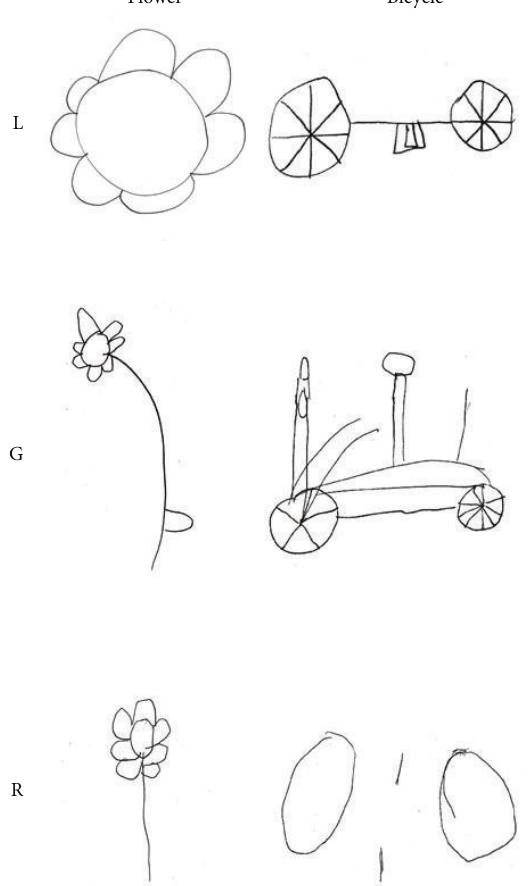
Figure 3: Examples of drawings from memory performed by L., G., and R. (a flower, a house, and a bicycle). Drawings were based on typical representations of objects. L. and R. limited their drawings of a bicycle to the emerging details (wheels).